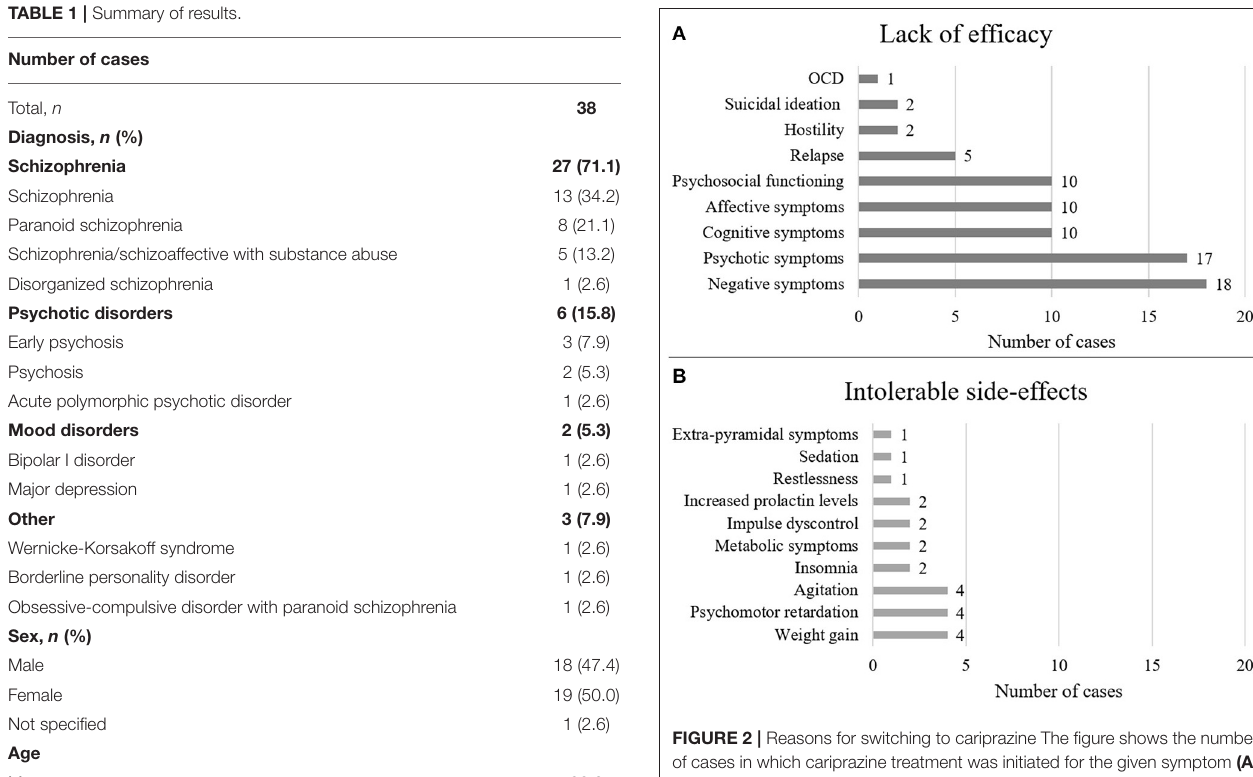
or the given side-effect (B)